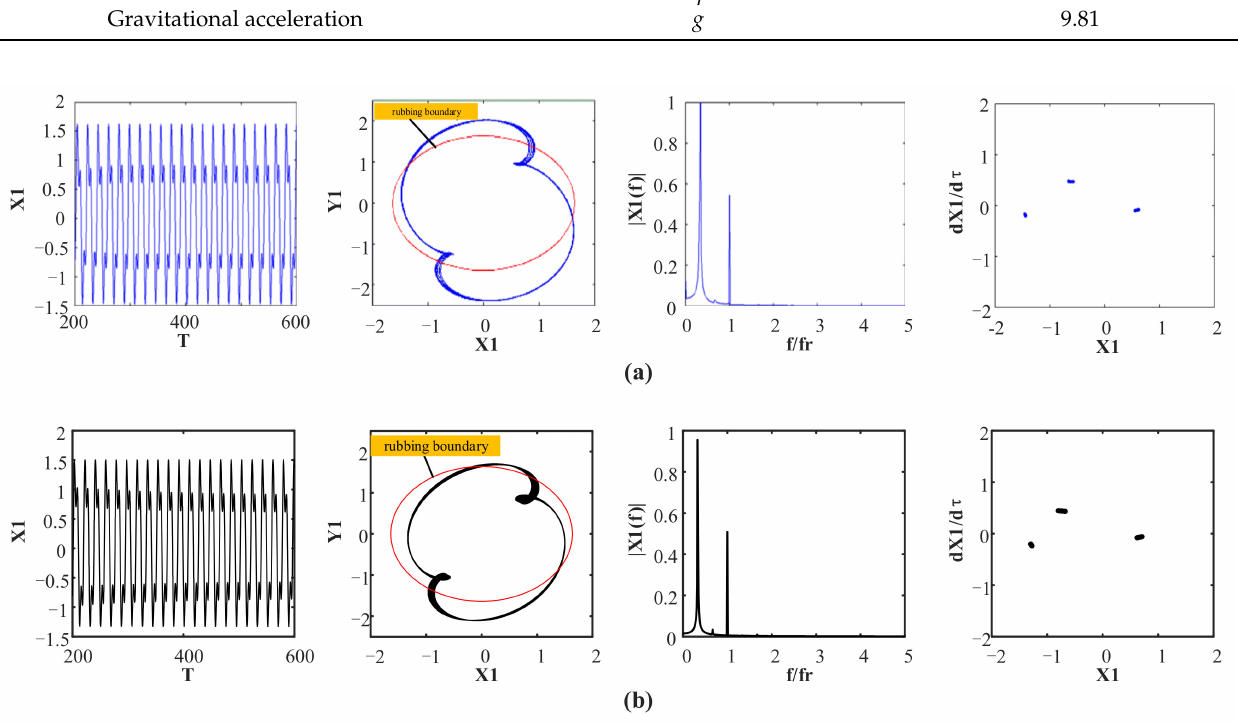
Figure 4. Comparison of the simulation results of the present paper and Ref. [33] at ω = 1750 rad/s: ( a ) Results in Ref. [34]; ( b ) Results of the present